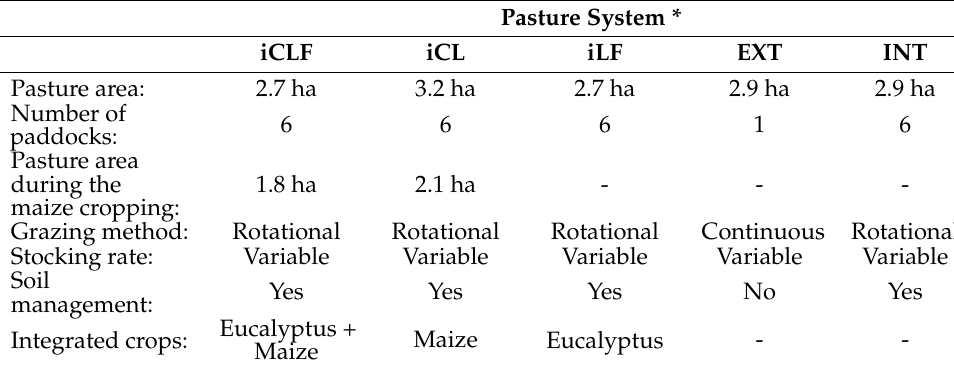
Table 1. Characterization of the pasture systems by repetition